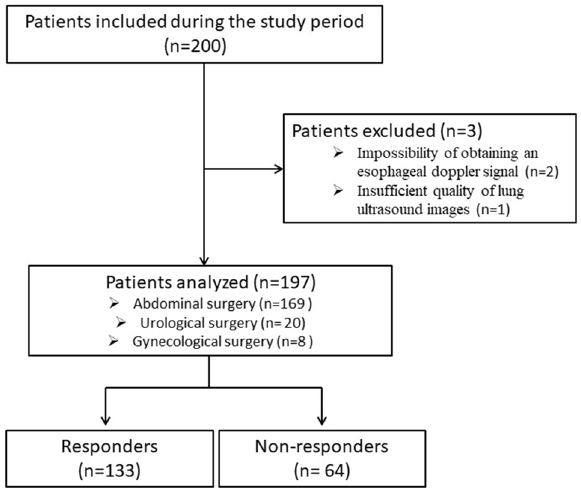
Figure 3. Flow chart of the